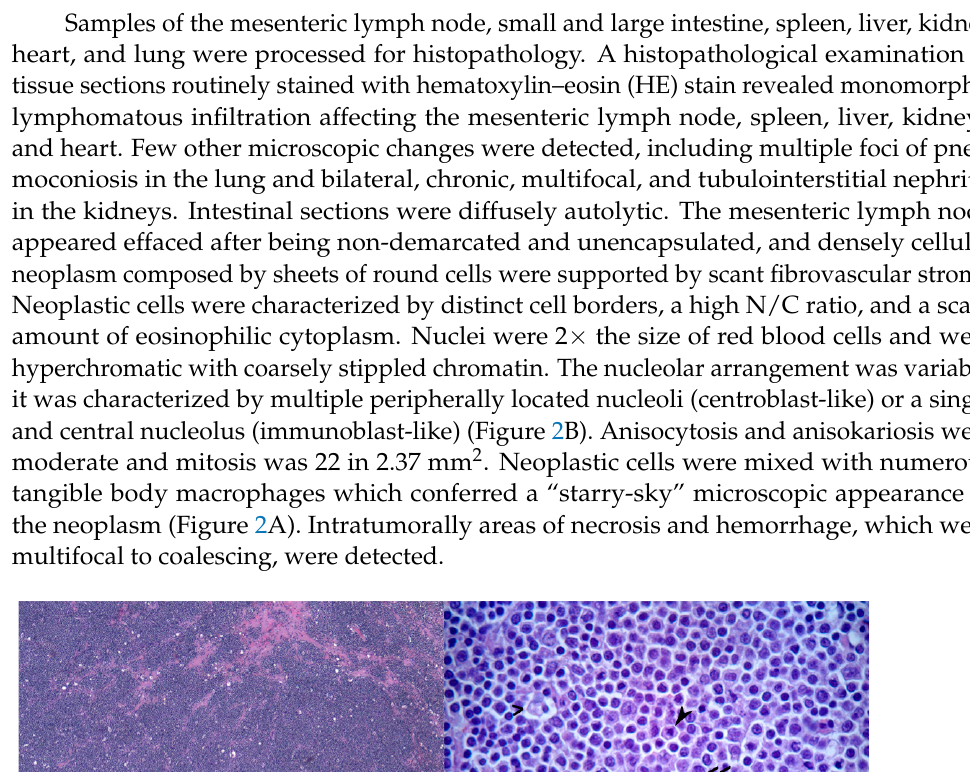
Figure 2. Diffuse large B-cell lymphoma (DLBCL) in raccoons. ( A ) A typical “starry sky” appearance resulting from sheets of round neoplastic cells mixed with scattered histiocytes containing phagocytosed cellular debris. ( B ) Tangible body macrophages containing phagocytosed debris at high magnification (>); nucleolar arrangements of the neoplastic cells are both centroblastic (<<) and immunoblastic (arrow); mitoses are numerous (arrowheads). Hematoxylin–eosin (HE). ( A ) Magnification 40×; ( B ) magnification 630×.